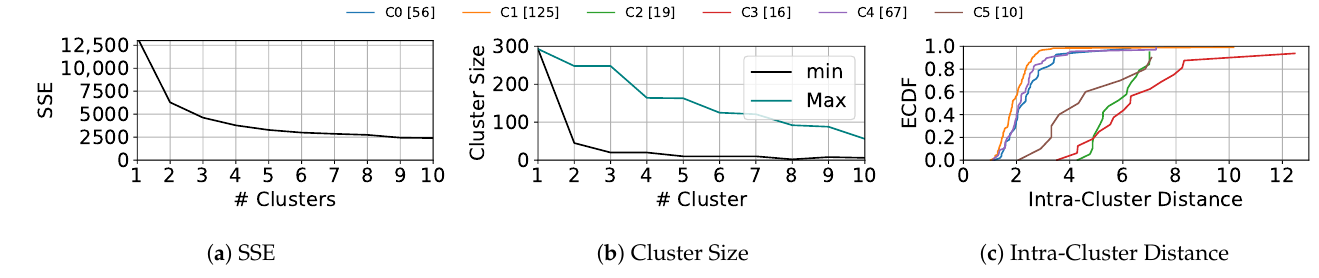
Figure 10. Cluster Metrics Working Station 1 Clamp 1 ws b .